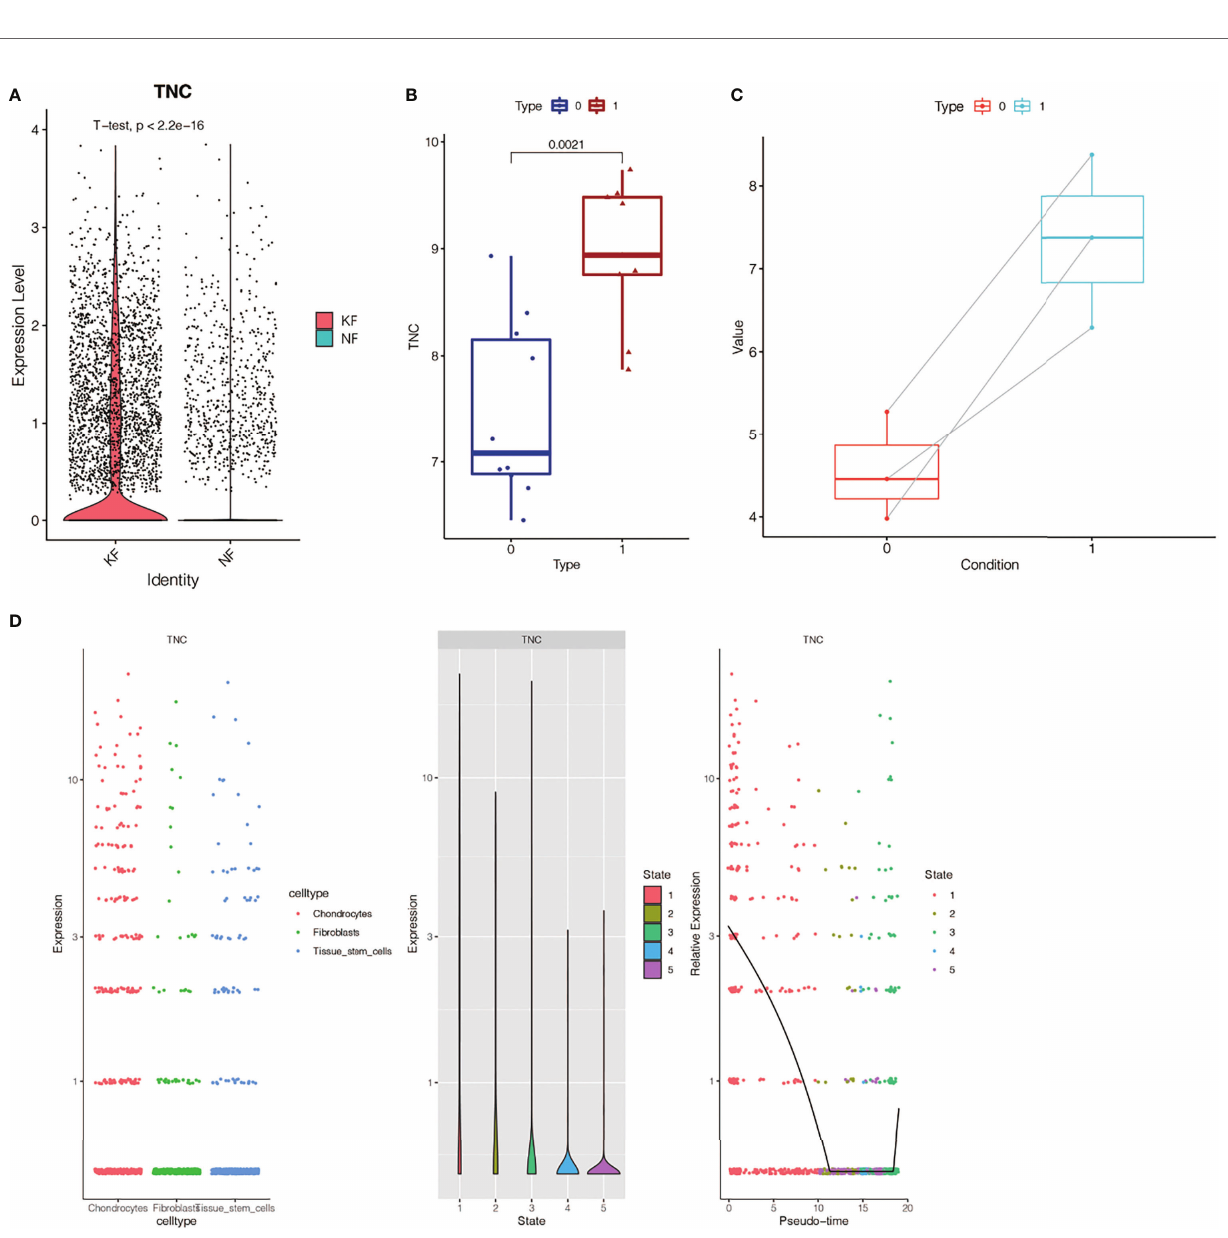
FIGURE 7 | Expression of TNC gene in keloid and normal tissue. (A) Analysis of TNC expression in single cell sequencing dataset GSE163973. TNC expression in keloids was different from that in normal tissues (P < 2.2E-16). (B) TNC expression analysis in dataset GSE44270. Group 1 was keloid group, and group 0 was normal control group. TNC expression is up-regulated in keloid. (C) RNA-sequencing data in our center showed that TNC expression was up-regulated in keloid. (D) Correlation analysis between TNC and fi broblast differentiation. The expression of TNC gene decreased fi rst and then increased with the differentiation of fi